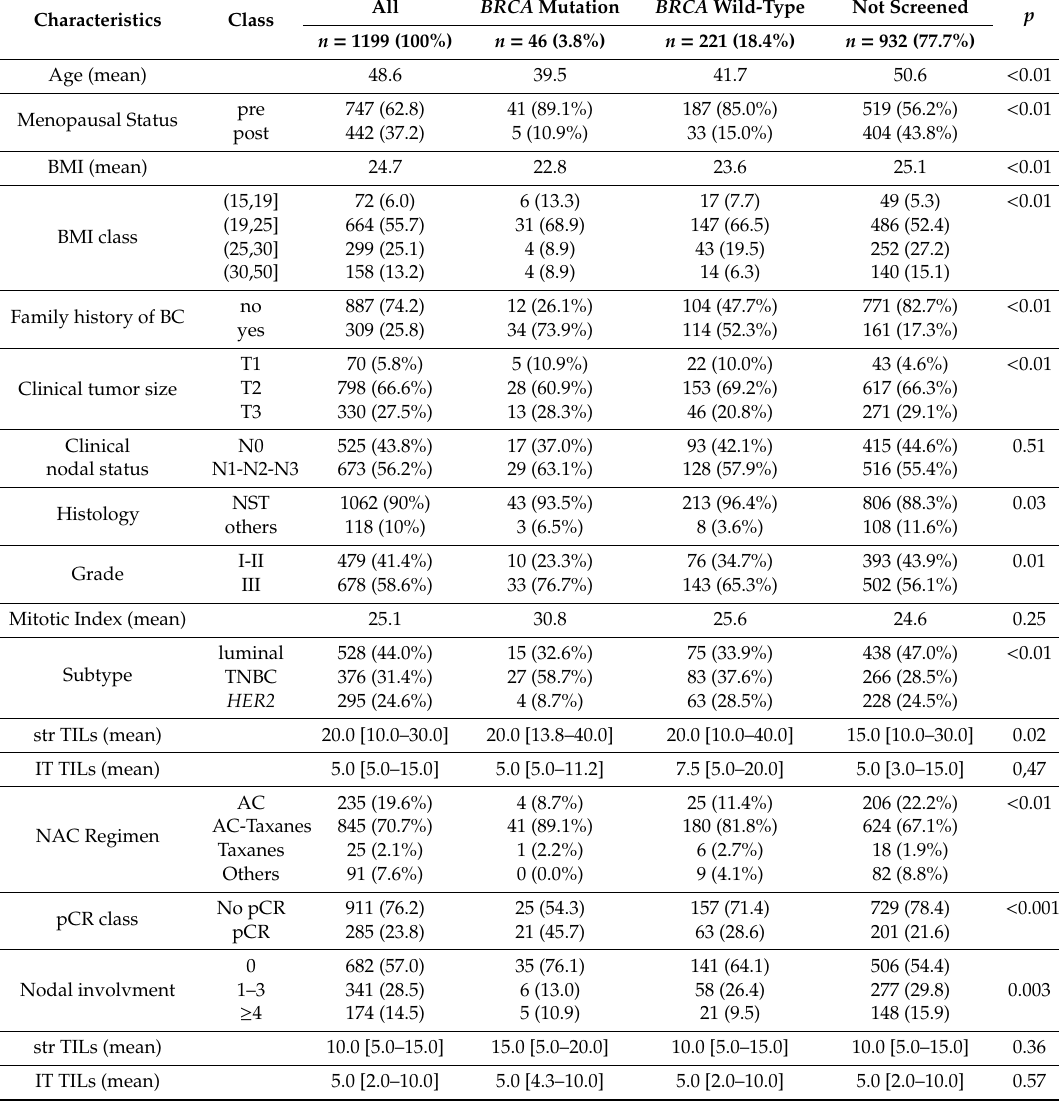
Table 1. Patients’ characteristics among the whole